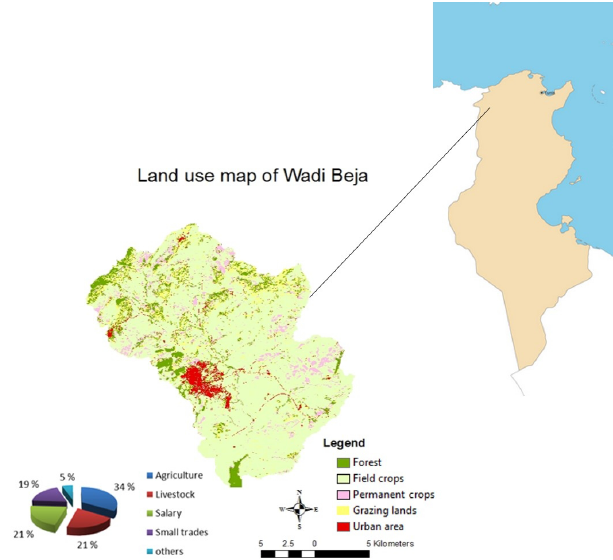
Figure 1. Characterization of household income, location, and land uses of the study area, Wadi Beja watershed, north-western Tunisia. Source: Jendoubi et al.